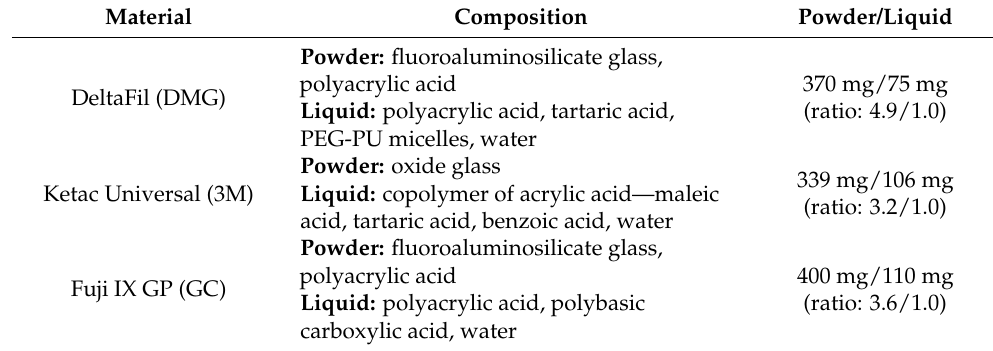
Table 1. Material compositions and powder/liquid ratios of the used glass ionomer restorative materials. Material Composition Powder/Liquid Powder: fluoroaluminosilicate glass, DeltaFil (DMG) Powder: oxide